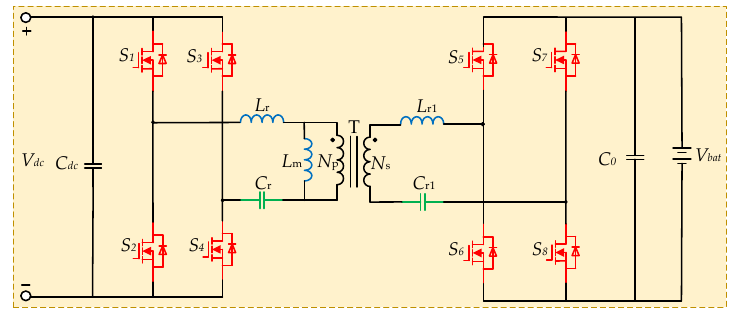
Figure 11. CLLC resonant converter.